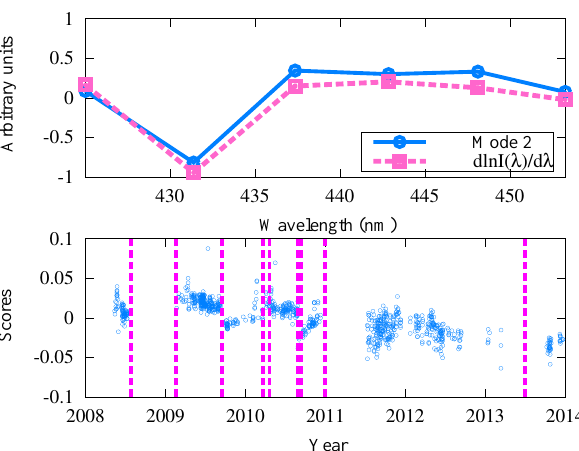
Figure 13. Second component (carrying about 5% of the variance) from the PCA. The wavelength derivative of the solar spectrum is plotted together with the mode of variation in the upper figure. In the lower panel, the corresponding scores (points) are drawn to- gether with the events (dashed lines) that could potentially affect the wavelength alignment of the Brewer.